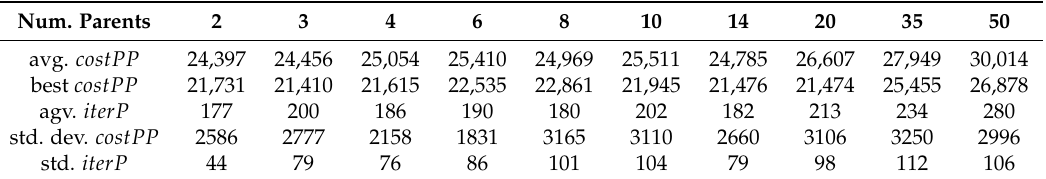
Table 3. The product placement cost costPP as sum of order picking route lengths (the lower the better—see Equation 2) and number of iterations iterP to obtain this cost for a modified multi-parent AEX crossover operator for the warehouse size of 232 locations and a list of 80 orders, using an 8-parent HGreX for route optimization (averages of 10